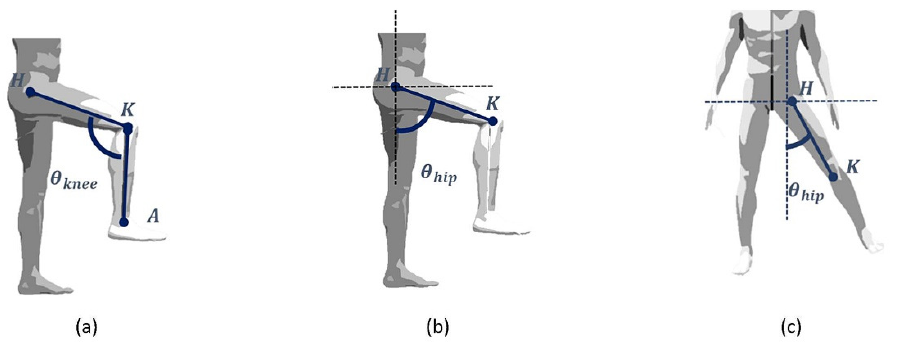
Figure 5. A simplified human joint/bones model of the lower limbs during ( a ) flex/extension of the knee, ( b ) flex/extension of the hip and ( c ) ab/adduction of the hip.